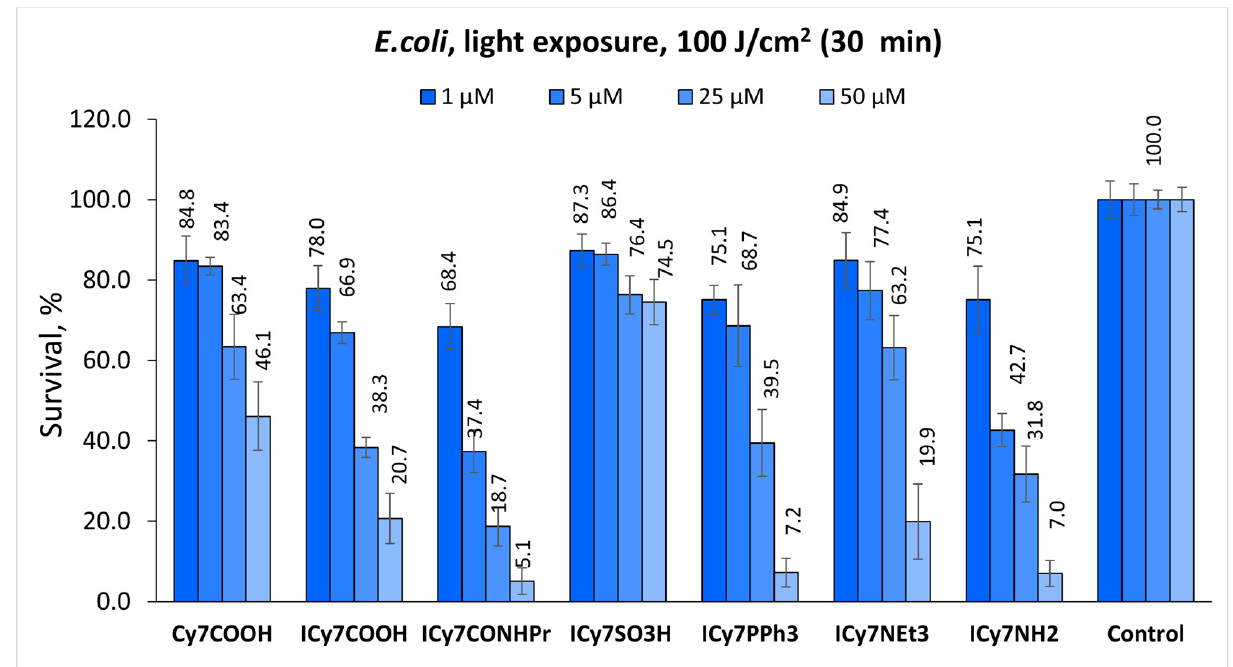
Figure 5. Survival of E. coli in saline containing 0.7% DMSO, when exposed to 100 J/cm 2 light dose (56 mW/cm 2 , 30 min) vs. the dye concentrations.